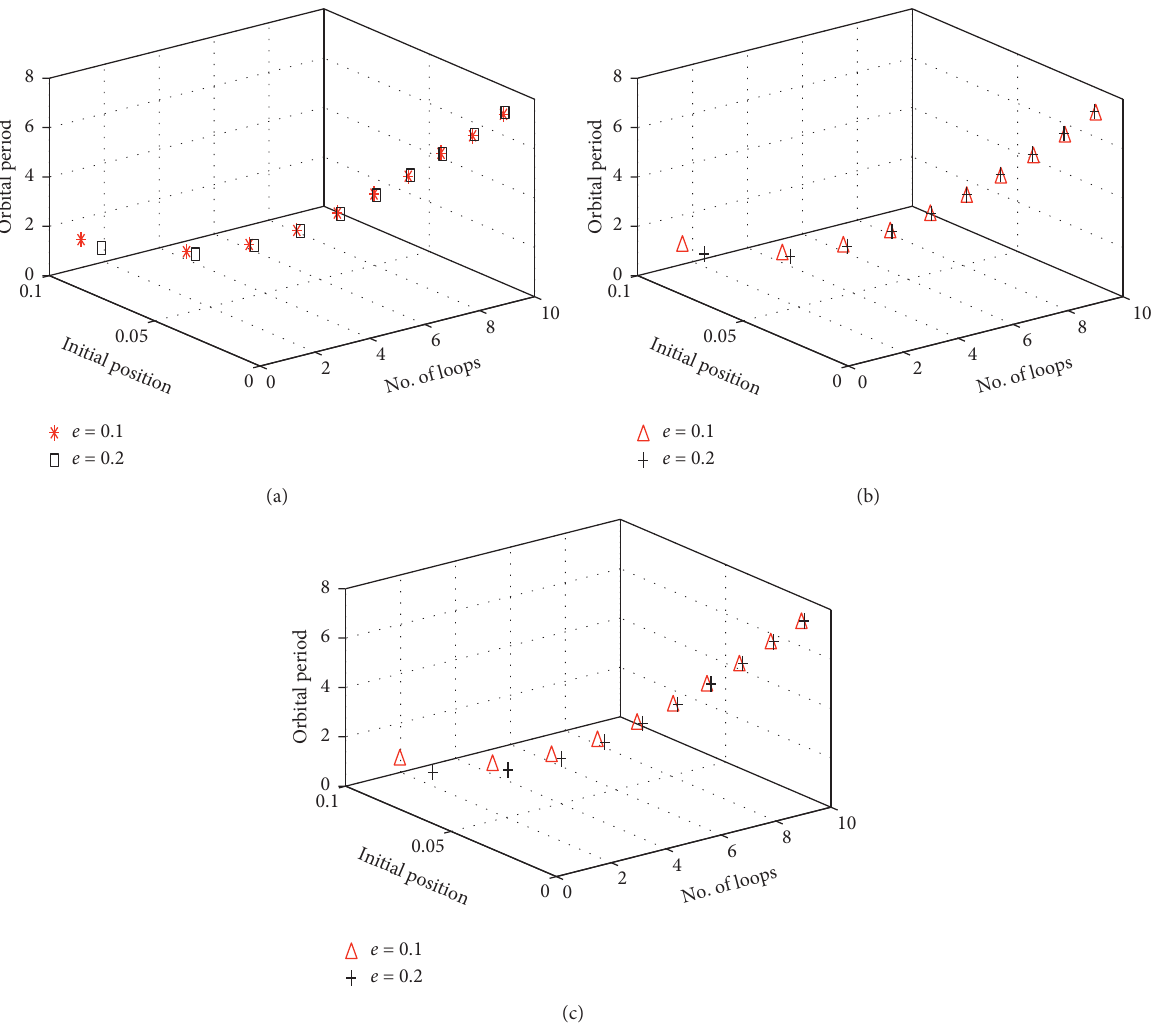
Figure 13: Variation in the initial position and orbital period, when velocity is (0, 0.002, 0). (a) f 0 � π /6. (b) f 0 � π /3. (c) f 0 � π